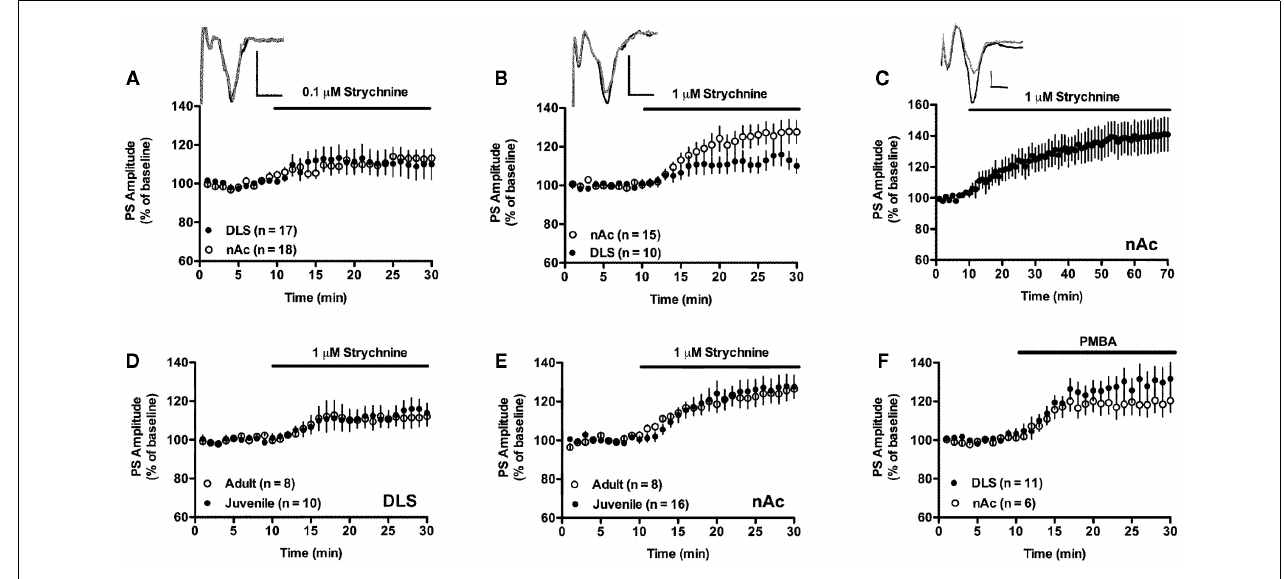
15–20min exposure to 1 μ M strychnine (black) in the DLS. (C) The enhancing effect displayed by strychnine was not depressed over time. Example traces show evoked PSs at baseline (gray), and after 50–55min exposure to 1 μ M strychnine (black) in the nAc. (D,E) Strychnine enhanced PS amplitude to a similar extent in slices from adultWistar rats. (F) PS amplitudes in the DLS and in the nAc were also enhanced by the glycine receptor antagonist PMBA (50 μ M). Data show mean PS amplitudes compared to baseline with SEM. Calibration: 0.2mV,